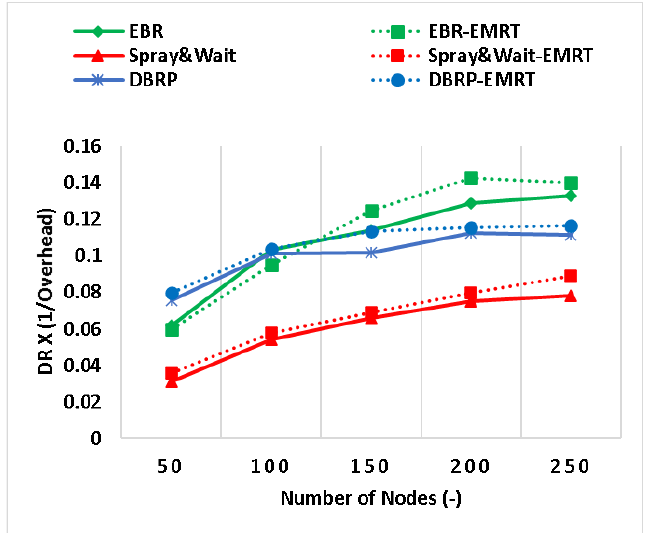
Figure 6. The DO composite metric (DR × (1/overhead)).